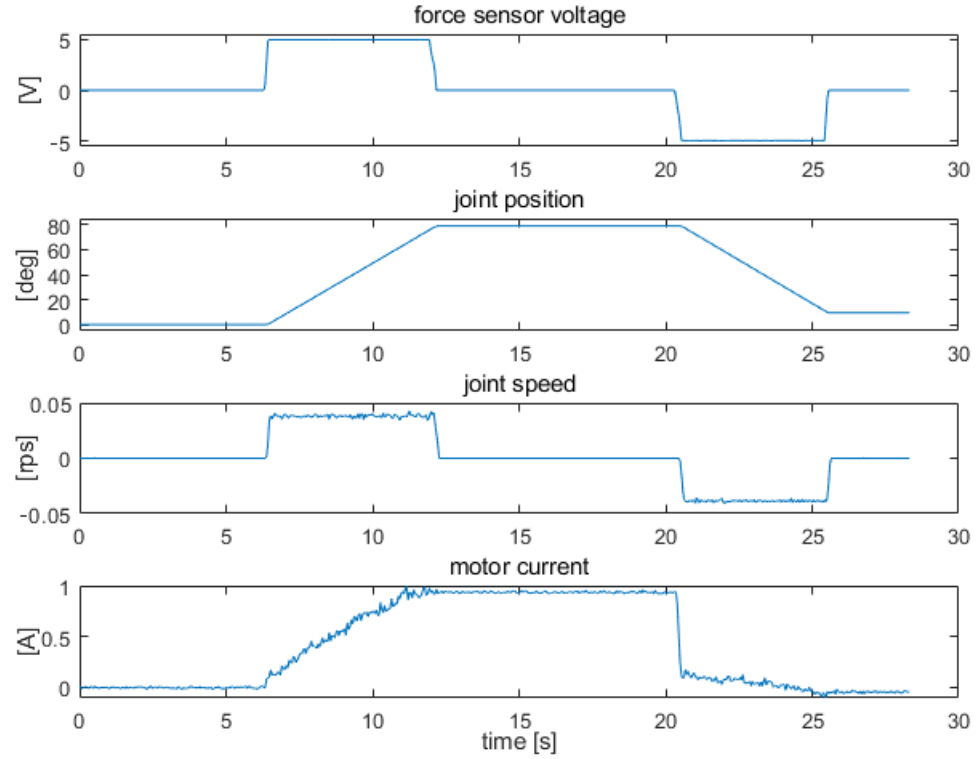
Figure 9. Signal waveforms from force, position, speed, and supply current sensors for elbow joint drive under strong constant force on the sensors.